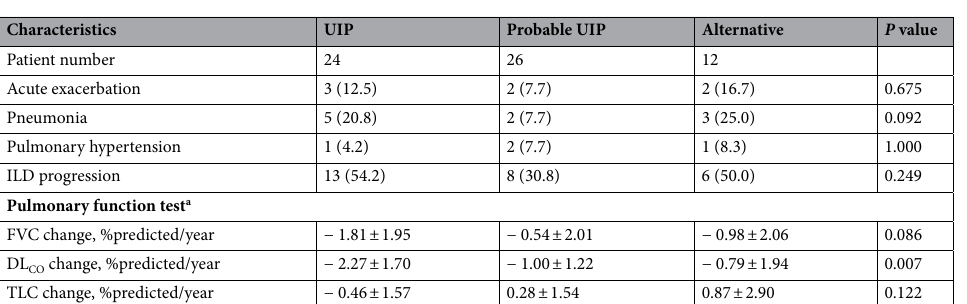
Table 3. Comparison of clinical course according to HRCT patterns among patients with SJS-ILD. Data are presented as mean ± standard deviation or number (%), unless otherwise indicated. DL CO diffusing capacity of the lung for carbon monoxide, FVC forced vital capacity, ILD interstitial lung disease, SJS Sjögren syndrome, TLC total lung capacity, UIP usual interstitial pneumonia. a Lung function decline rate was defined as the slope of the linear function estimated using a linear mixed-effects model with random intercept and random